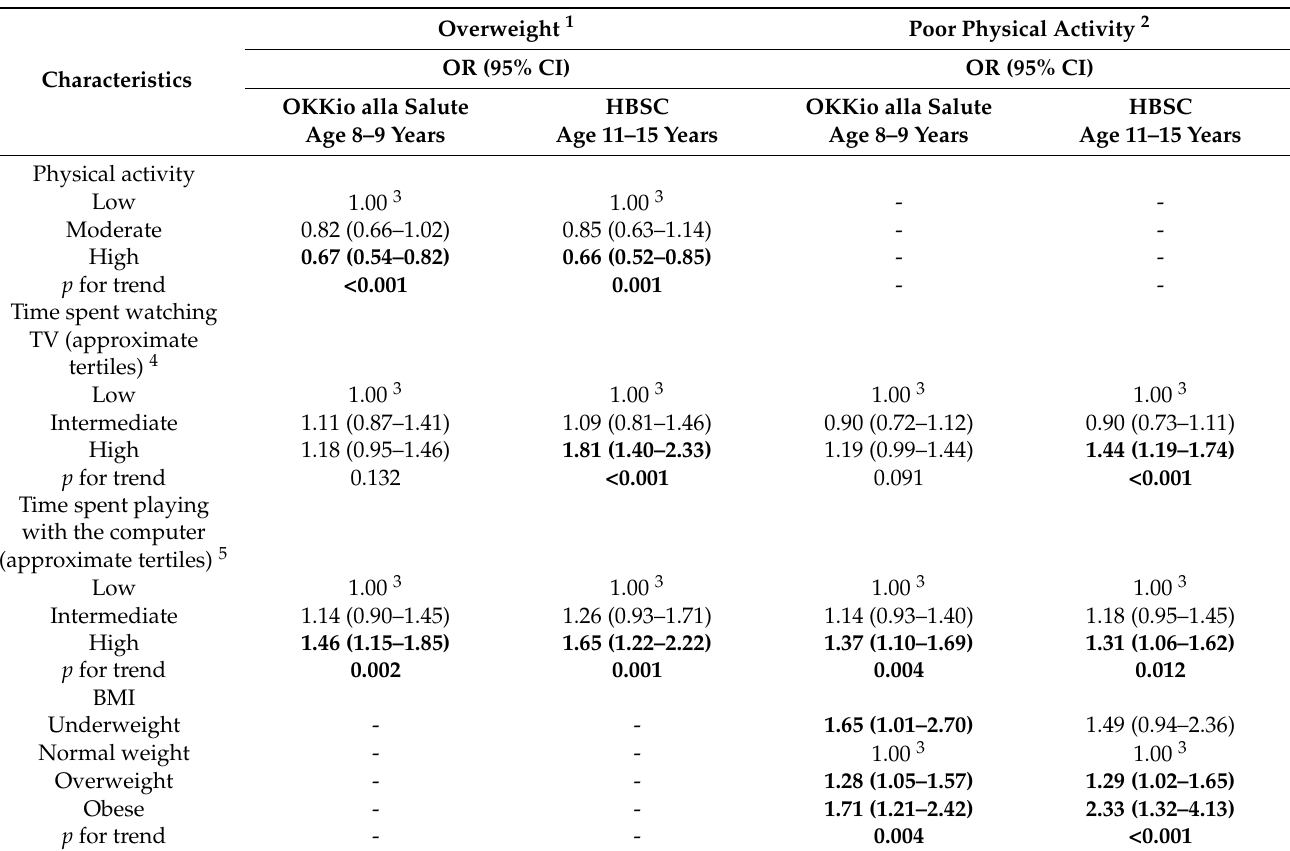
Table 3. Odds ratios (OR) and corresponding 95% confidence intervals (CI) for childhood over- weight (including obesity) and poor physical activity according to selected lifestyle habits and other characteristics. Lombardy,